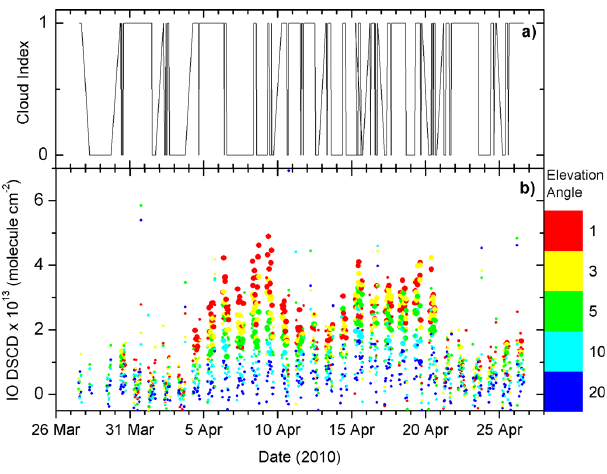
Fig. 3. MAX-DOAS observations of IO DSCDs made during the HaloCAST-P cruise. Panel (a) shows the cloud index during the cruise (1 – cloudy, 0 – not cloudy). Panel (b) illustrates the IO DSCDs with the statistically significant values as larger circles. The elevation angles for the observations are indicated in the